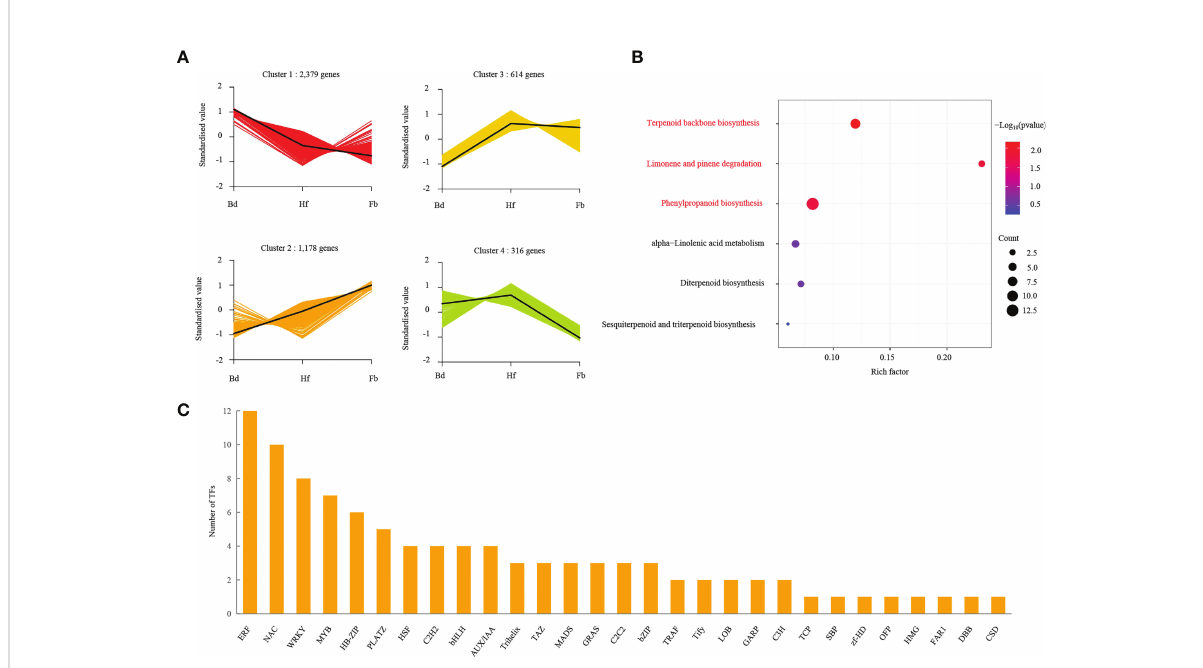
FIGURE 8 Gene regulation during fl owering process. (A) K-means cluster analysis of co-expression gene and their expression pattern. (B) Aroma-related pathway enrichment analysis of DEGs in cluster 2, and pathways with signi fi cant enrichment were highlighted in red color. (C) The DEGs involved in transcriptome factors in cluster 2. Pathways with signi fi cant enrichment were highlighted by red